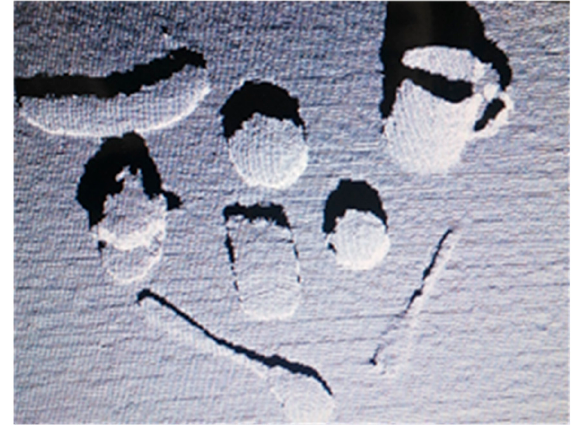
Figure 6. Point cloud image of grasped objects.